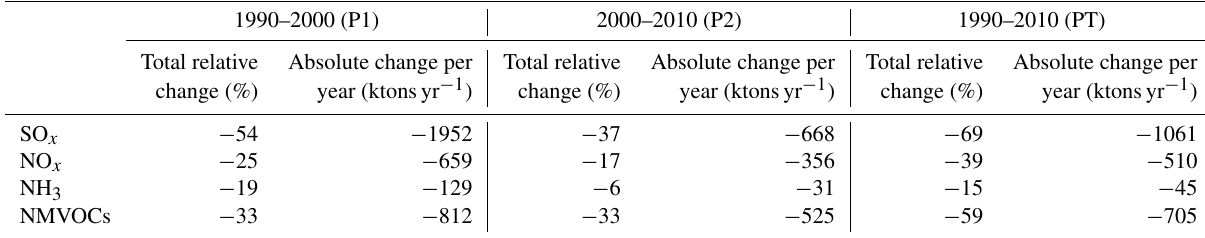
Table 2. Relative and absolute trends in emissions of SO x , NO x , NH 3 and NMVOCs in the EURODELTA-Trends exercise (whole domain). Trends are reported for the entire 1990–2010 period as well as for two subperiods, 1990–2000 and 2000–2010. The linear trends were calculated using the Theil–Sen method (Sen,